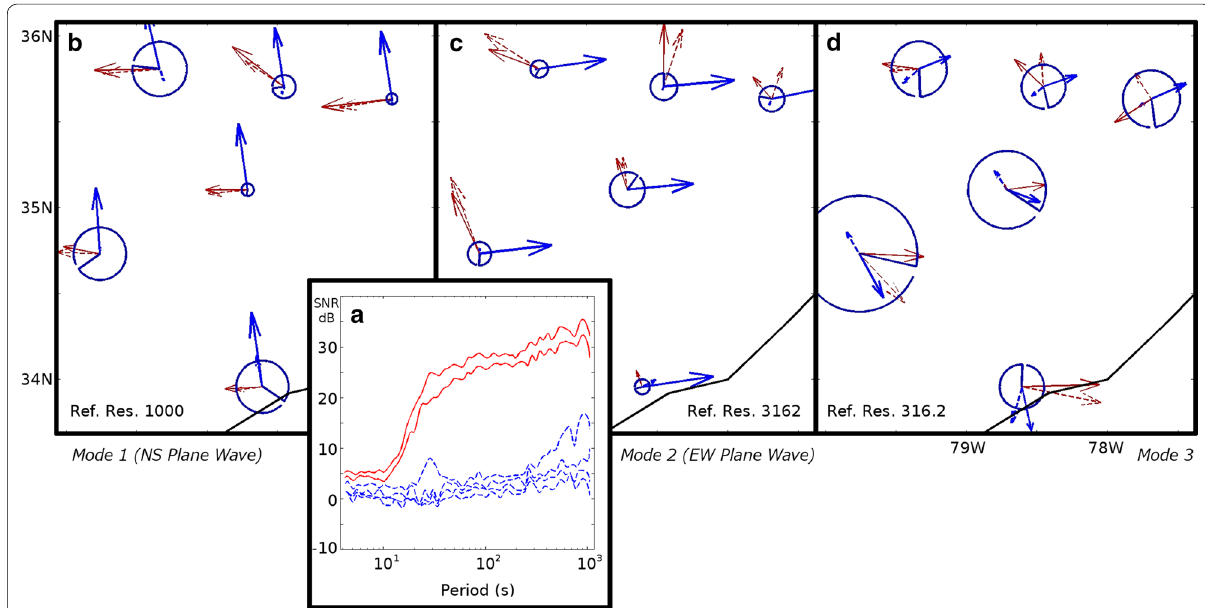
Fig. 3 Results from frequency-domain robust principal component analysis of electric and magnetic fields from the array shown in Fig. 1, which includes the two sites from the southeastern USA used in Fig. 2. a Power spectrum of six dominant modes, given in signal-to-noise units expressed in decibels (dB). Signal power above 0 dB indicates that the mode is above the incoherent noise level and therefore significant. If the uniform source assumption that underlies the MT method held exactly, there would only be two significant modes (shown in red). In the FLR period band for this array (~ 20–40 s), the curve for the third mode becomes significant. Additional significant modes at longer periods are also associated with source effects (primarily in the vertical magnetic fields) due to increasing skin depths with respect to large-scale source structure (e.g., Jones and Spratt 2002). b – d Linear combinations of the first three spatial modes at a period of 26 s, displayed as complex vectors plotted on a map of array sites. The first two panels show linear combinations, defined following the approach in Egbert (1997), that best approximate uniform magnetic sources, linearly polarized geomagnetically N–S and E–W. Panel d represents the remaining signal in the first three modes. This mode exhibits a clear north– south spatial gradient and very large vertical magnetic components, consistent with expectations for a spatially localized FLR signature. In these plots, horizontal magnetic (electric) fields are shown with blue (red) arrows, with real parts solid and imaginary parts dashed. The vertical magnetic field is shown with a blue circle, scaled as for the horizontal components to indicate amplitude, with the position of the drawn radius denoting phase. To scale the lengths of electric and magnetic field vectors in a physically meaningful way, a reference Earth resistivity (given in each panel) is